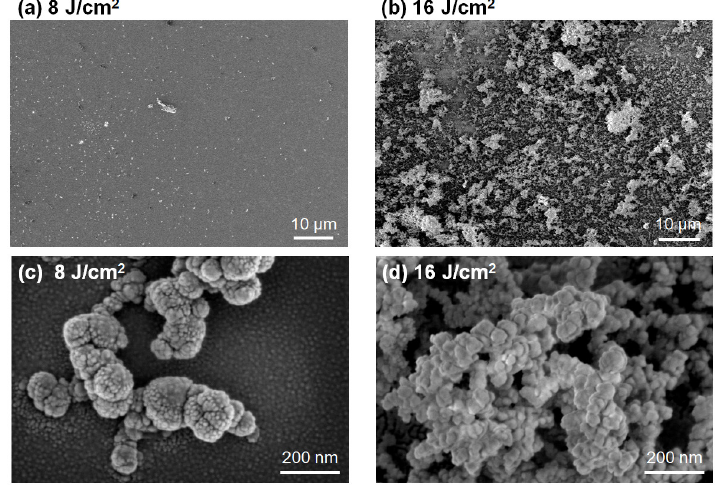
Figure 4. SEM images of the LTNS film obtained at ( a ) 8 J/cm 2 and ( b ) 16 J/cm 2 . ( c , d ) show higher magnification images.